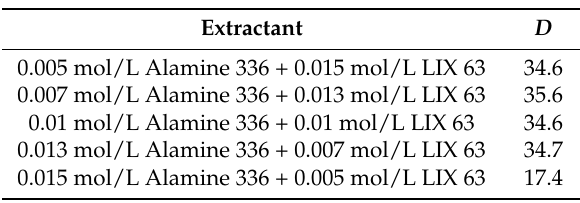
Table 9. Distribution ratio of Pd(II) by varying the concentration of 5,8-diethyl-7-hydroxyldodecane- 6-oxime (LIX 63) and Alamine 336.